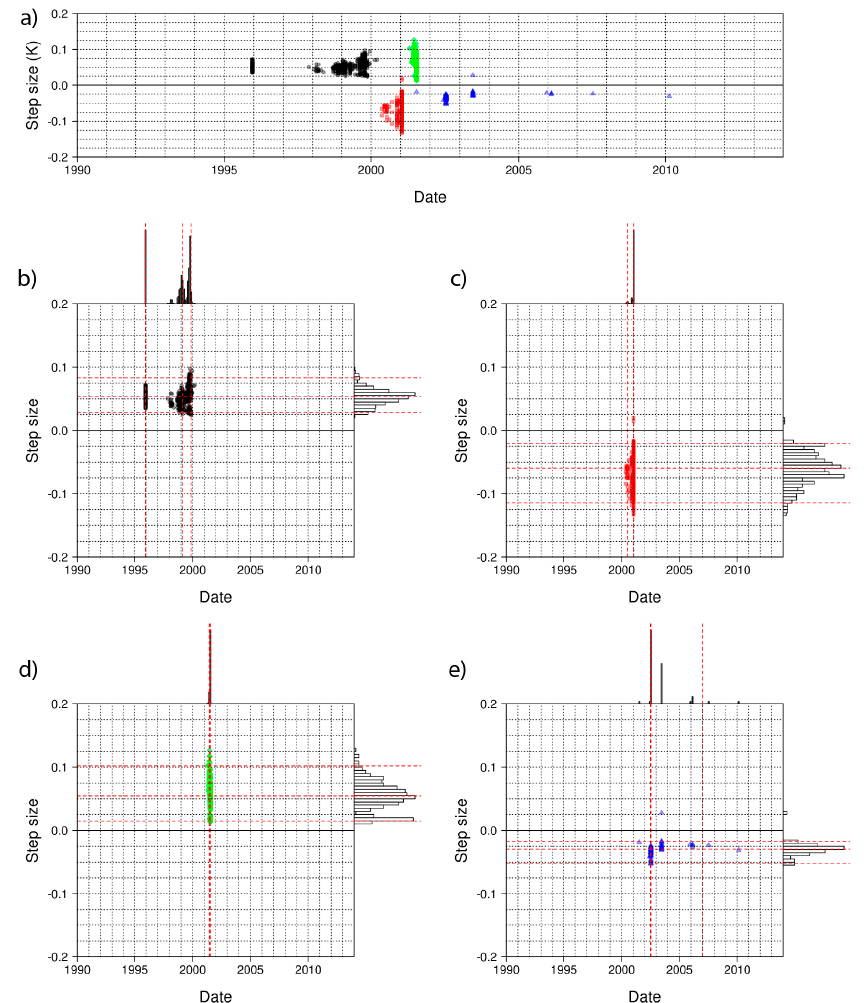
Figure 8. Scatter plot of the identified change point dates and step sizes for the drifting buoy analysis split into four groups. Panel ( a ) shows the steps identified over the full record—black represents break 1, red break 2, green break 3, and blue break 4. Panels ( b – e ) show scatter plots and histograms for the individual groups, the red dashed lines indicate the 2.5%, 50%, and 97.5%